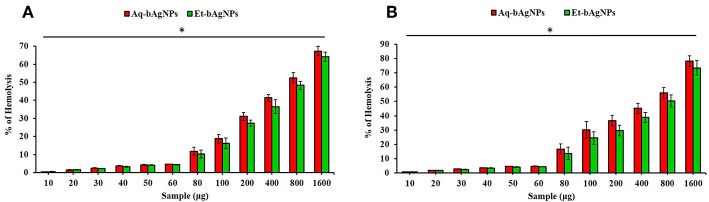
Hemocompatibility of bAgNPs to human (A) and rat (B) red blood cells (RBCs). The HC50 values of Aq-bAgNPs and Et-bAgNPs to human RBCs were 700 and 800 μg, respectively. However, the HC50 values of Aq-bAgNPs and Et-bAgNPs to rat RBCs were 600 and 800 μg, respectively. The hemocompatibility assay was performed three times on three different days. The values presented are mean ± SE of multiple samples (n = 3) and paired t-test was performed for analyzing significant difference between Aq-bAgNPs and Et-bAgNPs. The hemocompatibility of bAgNPs was significantly different from each other and *P ≤ 0.05.